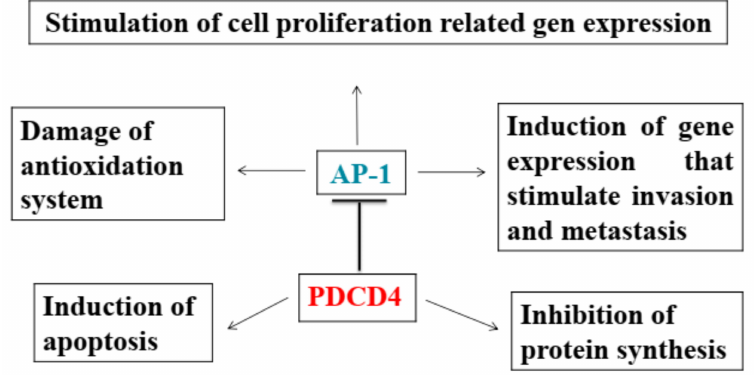
Figure 1. PDCD4, a tumor suppressor, suppresses carcinogenesis by